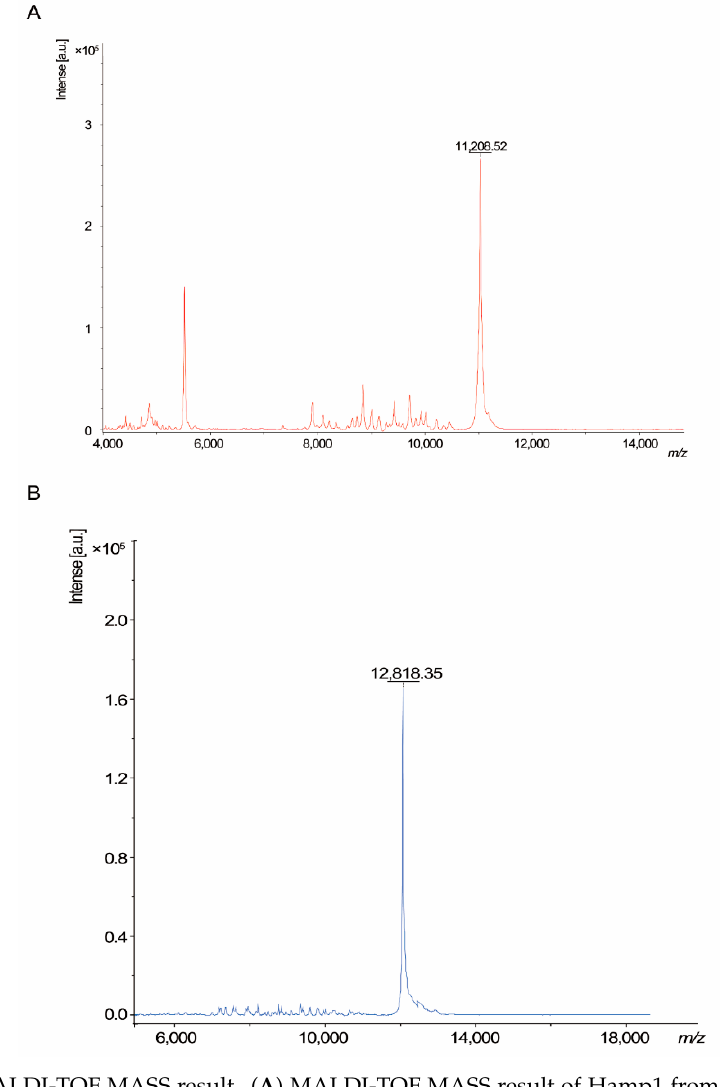
Figure 3. MALDI-TOF MASS result. ( A ) MALDI-TOF MASS result of Hamp1 from black rockfish. Figure 3. MALDI ‐ TOF MASS result. ( A ) MALDI ‐ TOF MASS result of Hamp1 from black rockfish. ( B ) ( B ) MALDI-TOF MASS result of Hamp2 from black MALDI ‐ TOF MASS result of Hamp2 from black rockfish.